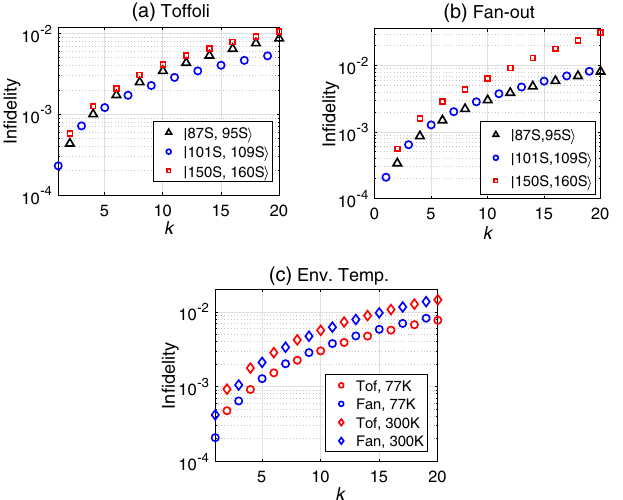
FIG. 6. Fidelity of dark-state gates as a function of qubit number k for (a,b) different Rydberg states presented in Table I and for (c) different environment temperatures. The environment temperature in panels (a,b) is T ¼ 77 K, and the Rydberg states in panel (c) are j 101 S; 109 S i . The ranges of dynamic parameters are stated in the